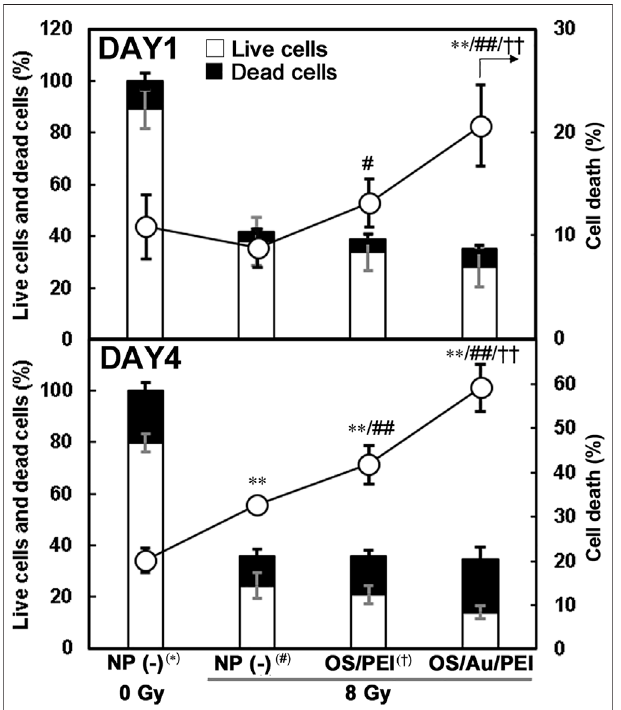
FIGURE 4 | Cell counts and cell viability of 4T1 cells treated with 30 μ g ml − 1 of NP (-), OS, OS/PEI, and OS/Au/PEI with X-ray irradiation. * Signi fi cantlydifferentfromthe4T1cellstreatedwith0 GyNP(-).#Signi fi cantly different from the 4T1 cells treated with 8 Gy NP (-). † Signi fi cantly different from the 4T1 cells treated with 8 Gy